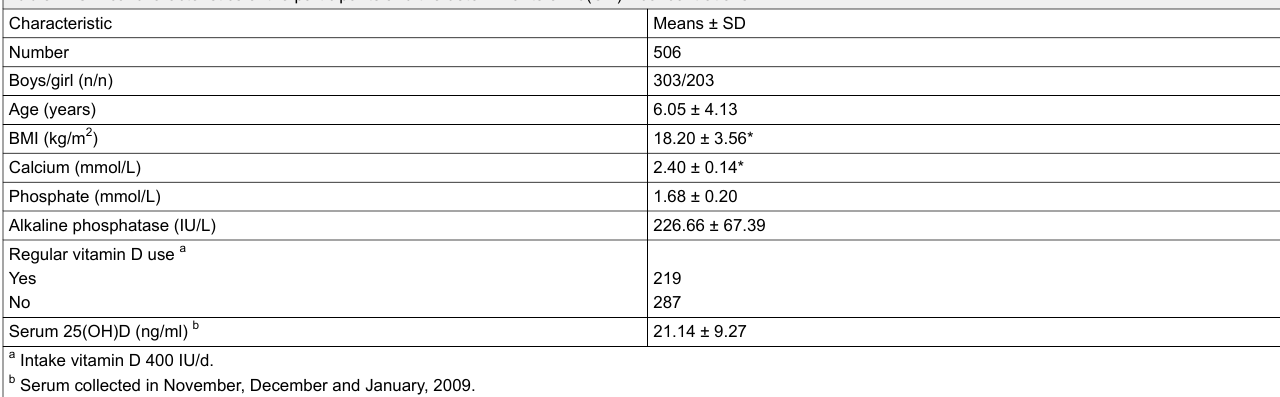
Table 1: Clinical characteristics of the participants and the determinants of 25(OH)D concentrations.